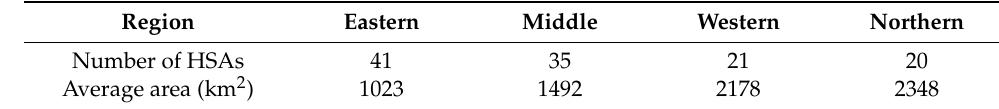
Figure 5. Spatial distribution of maternal HSAs. (Note : The number in Figure 5 represents HAS). Table 1. Statistics of HSAs in four